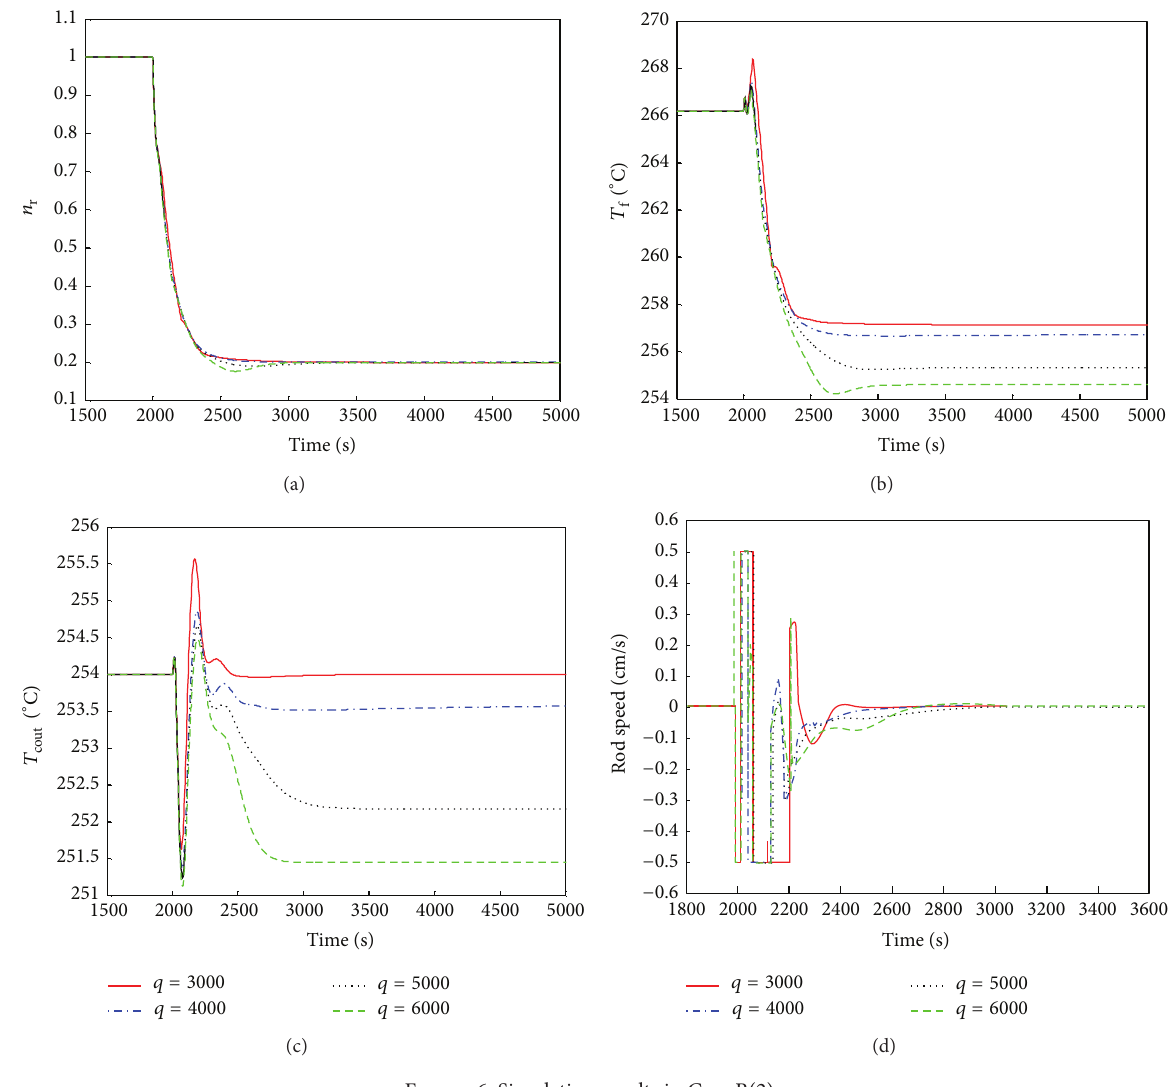
Figure 6: Simulation results in Case